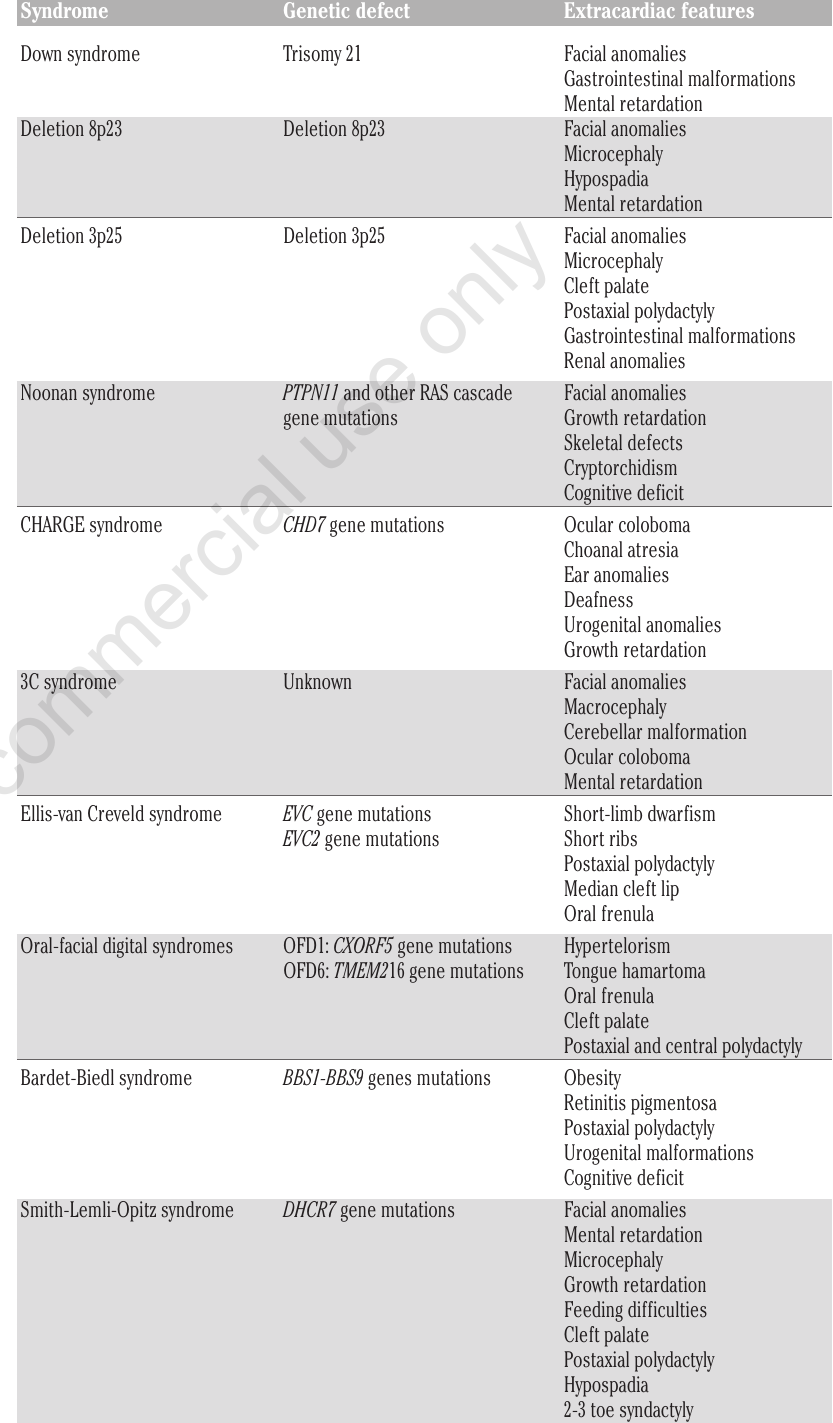
Table 1. Clinical characteristics of genetic disorders associated with atrioventricular canal